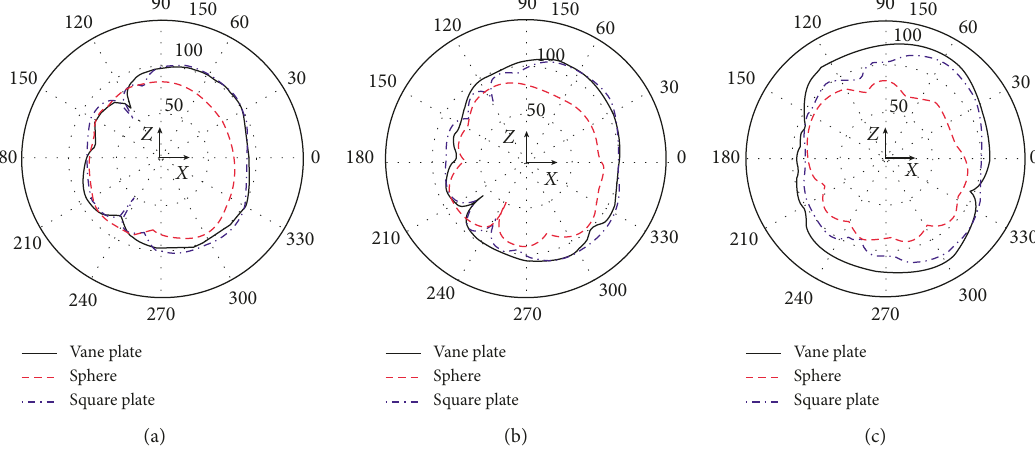
Figure 6: Sound pressure level characteristic curves of three different shape markers under typical frequency sound waves: (a) 7kHz frequency sound wave, (b) 10kHz frequency sound wave, and (c) 14kHz frequency sound